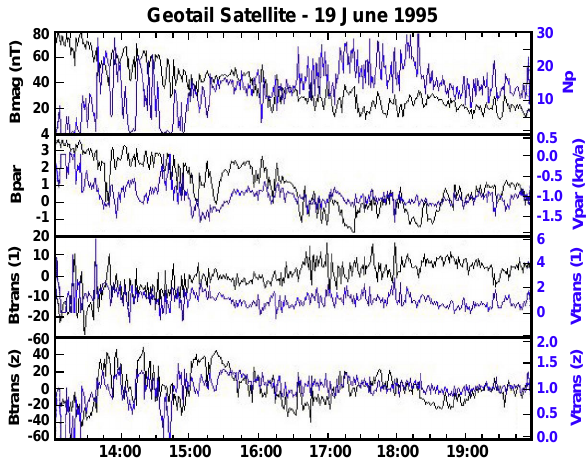
Fig. 10. PSD for Wind (top panel) and Geotail (bottom panel) on 19 June 1995. define two intervals of PSD increase, starting at 13:00 UT until about 16:00 UT, that could be related to the first two intervals at Wind, though in the magnetosheath the intervals have nearly merged and have similar frequency peaks below 4 mHz. The third interval at Geotail has peaks throughout the Pc5 frequency range in contrast to the third interval at Wind which has power only below 2 mHz. The fourth interval at Wind has no clear corresponding power at Geotail, and the fifth interval is small, both at Wind and Geotail. Throughout the region there are peaks in Pc5 wave power that fall primarily between 1 and 5 mHz in the solar wind (Fig. 10 top panel) and between 1 and 7 mHz in the mag- netosheath (bottom